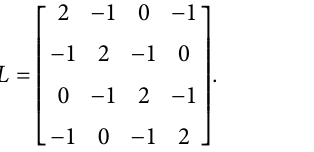
− w i i . (b) Trajectory of